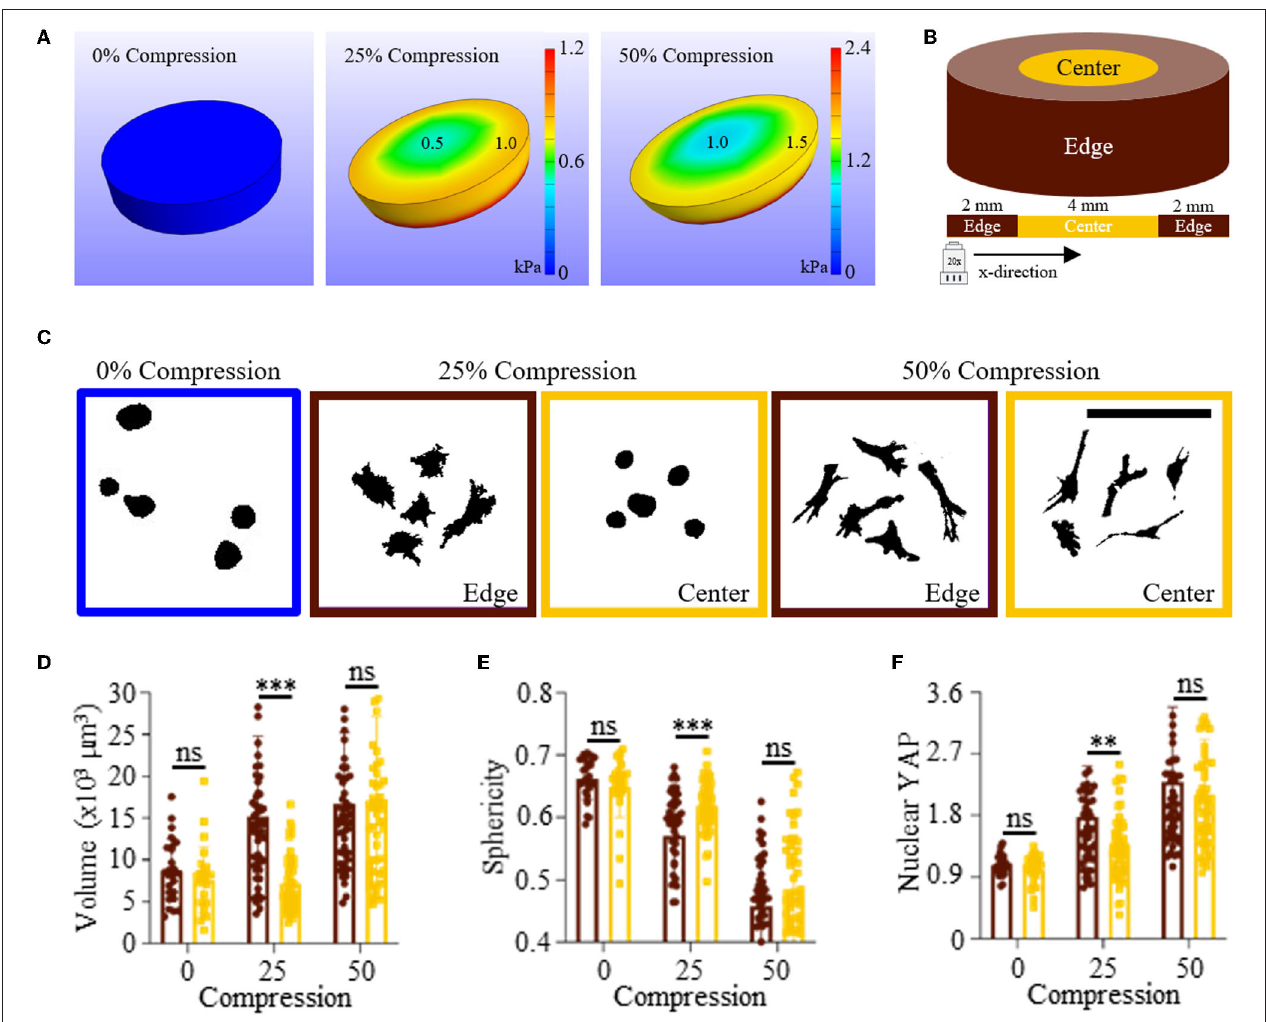
FIGURE 2 | Differences in hydrogel stress during compression influence MSC spreading and nuclear YAP localization in GelMe hydrogels. (A) Finite element analysis models of uncompressed (left), 25% (middle), and 50% (right) compressed hydrogels. (B) Schematic of hydrogel showing edge (brown) and center (gold) regions for the whole hydrogel and along the x-direction. (C) Representative single cell silhouettes of single MSCs encapsulated in uncompressed, 25% compressed, and 50% compressed GelMe hydrogels. Quantification of cellular (D) Volume, (E) Sphericity, and (F) Nuclear YAP of MSCs encapsulated in edge (brown) or center (gold) GelMe hydrogels undergoing 0, 25, or 50% compression. Bar graphs represent the mean and points individual cells; n > 50 cells per group, ns, not significant, ** p < 0.01, *** p < 0.001. Scale bar: 100 µ